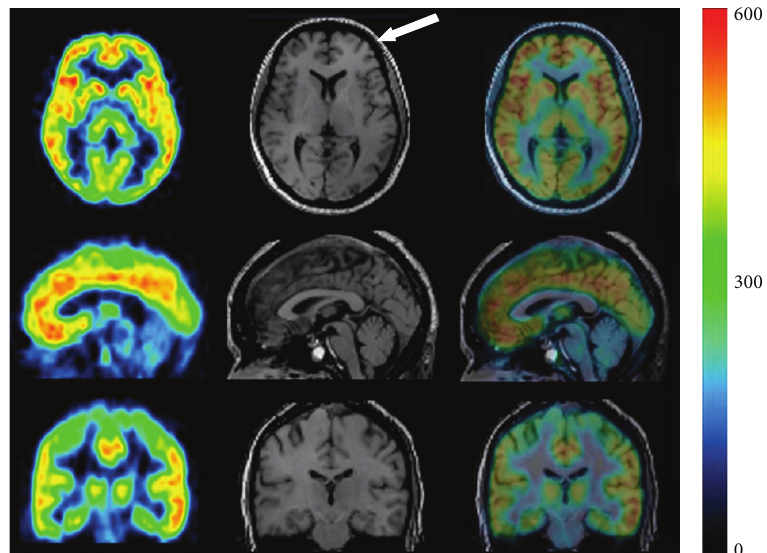
Figure 14: PET/MR images of [ 18 F]SP203 (60–180 min) in healthy subject. Arrow points to subcutaneous fat [101].